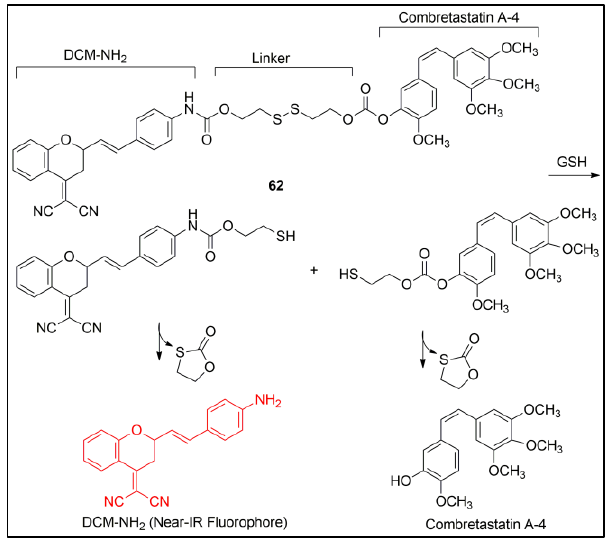
Figure 57. Mechanism of 62 disulfide bond cleavage [166].